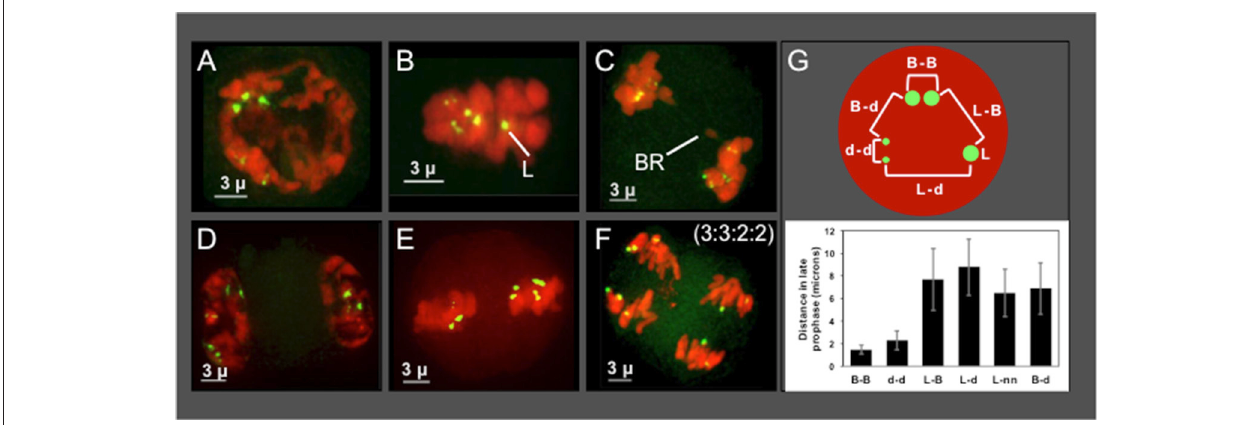
FIGURE 7 | Plant 255A 5S rDNA FISH signal images through meiosis and distance mapping in late prophase. Projections of 3D FISH datasets were produced as described in Figure 1 but with DAPI shown in red and 5S rDNA FISH, green. (A) Early diplotene showing three bright 5S rDNA dots and two smaller and dimmer signals, referred to as the 5-locus pattern. (B) Metaphase I showing two dim double dots, representing homologous pairs of sister chromatids, and three bright dots, one of which is alone and designated the lone (L) signal. (C) Anaphase I showing a bridge (BR) and 5S rDNA FISH signals as 2 pairs (upper left) and 3 pairs (lower right). 5S rDNA FISH signals at (D,E) Telophase I (D) metaphase II (E) , and anaphase II (F) indicating the 5S rDNA FISH signal ratios (3:3:2:2) in the daughter nuclei. (G) Top: Schematic of pairwise distance measurements within a nucleus with FISH signals indicated (B, bright; d, dim; L, lone). Each distance mapped is represented by a bracket. Bottom: Graph of distance averages in microns. The length of the scale bars (3 microns) is indicated.